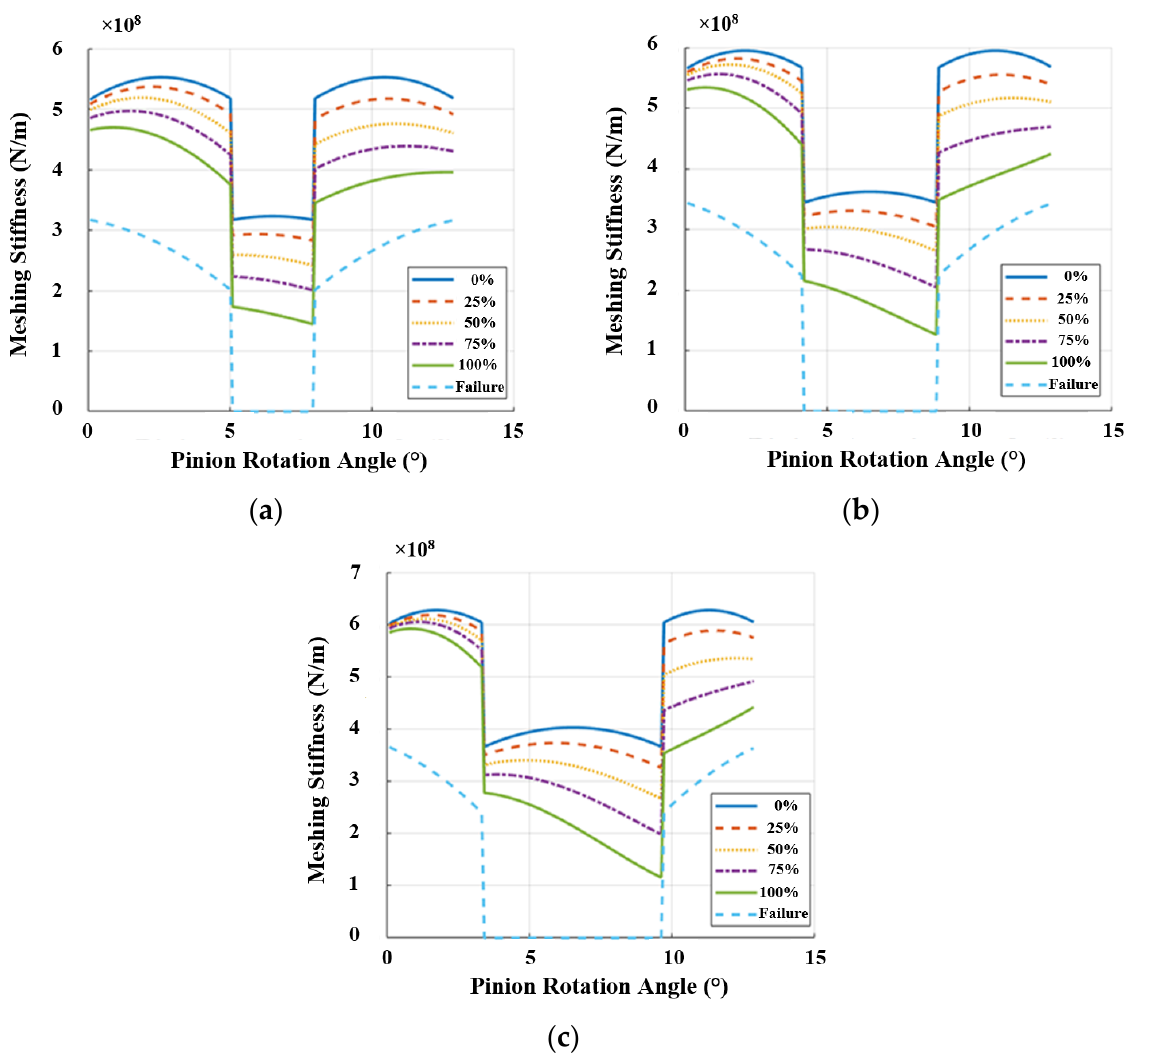
Figure 5. The meshing sti ff ness results in the presence of a tooth crack: ( a ) 20°/20°; ( b ) 20°/25°; ( c ) 20°/30° tooth pro fi les.